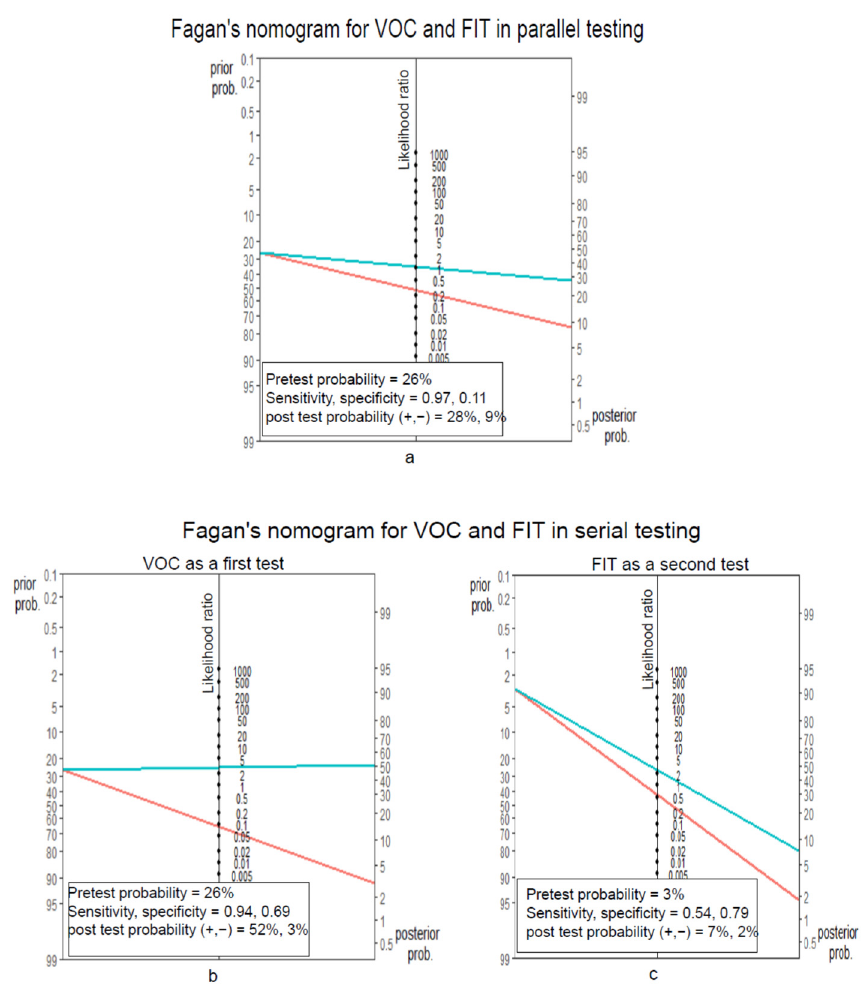
Figure 5. Fagan’s nomograms illustrating the pre-test and post-test probabilities of volatile organic compounds (VOC) and faecal immunochemical test (FIT) in ( a ) parallel testing and ( b,c ) serial testing, for the detection of a high-risk finding (as per the BSG guidelines. In serial testing, VOC is applied as a first test ( b ), and FIT is applied as a second test ( c ). The post-test probability of having a high-risk finding in a VOC-negative group has been considered as the pre-test probability for FIT. The probability reduction for parallel testing is 17%, and for serial testing, it is 24%. The green line corresponds to a positive test, and the red line to a negative